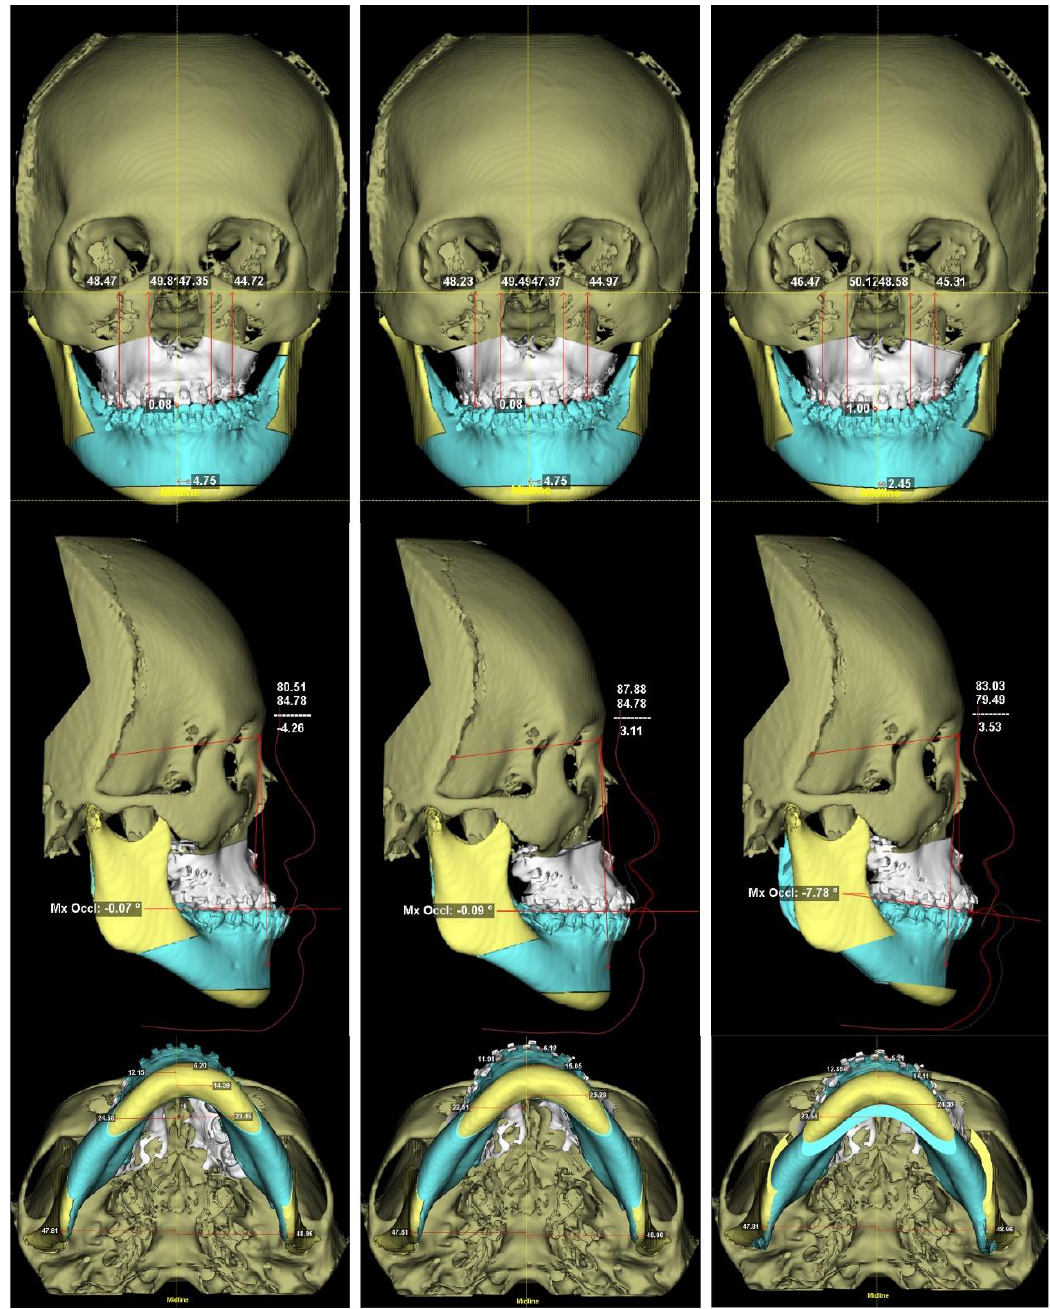
Figure 1. A case with left cleft lip and palate showing the frontal, lateral, and basal views of 3D surgical simulation using Dolphin 3D software. ( Left ) Preoperative 3D cephalometric images showing skeletal class III (SNA:80.51 ◦ , SNB: 84.78 ◦ , ANB: − 4.26 ◦ ), occlusal plane cant (U6R-FH plane: 48.47 mm, U6L-FH plane: 44.72 mm), and chin deviation (Pog deviation of 4.75 mm toward the left side). ( Middle ) One-jaw surgical plan with maxillary advancement alone. A point of maxilla was advanced 7.24 mm. Skeletal class I was achieved (ANB: 3.11 ◦ ) without correction of the occlusal plane cant and chin deviation. ( Right ) Two-jaw surgical plan with a combination of maxillary advancement and mandibular setback osteotomy and rotation. Skeletal class I was achieved by A point advancement of 2.43 mm, B point setback of 8.99 mm, and clockwise (pitch) rotation of 7.69 ◦ . Roll rotation ( − 3 ◦ ) and yaw rotation (5 ◦ ) were applied to avoid bony collision and to correct the occlusal plane cant and chin